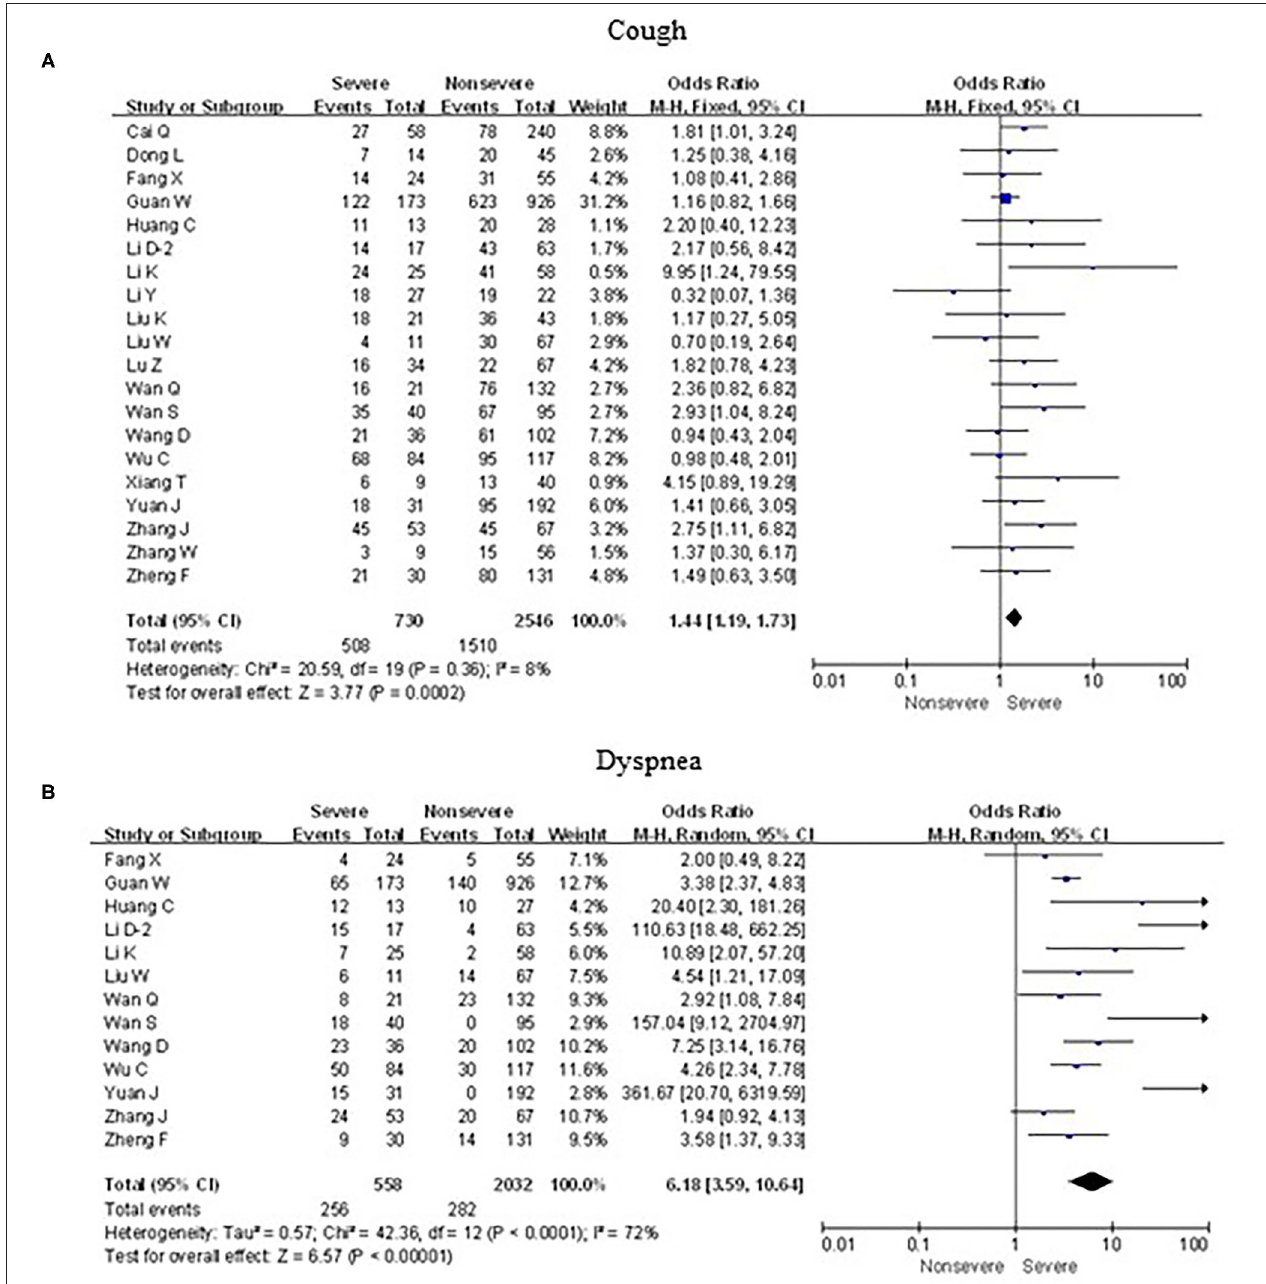
FIGURE 5 | Forest plots of odds ratios (ORs) showed the associations between respiratory symptoms, including cough (A) as well as dyspnea (B) , and disease progression of COVID-19 pneumonia.